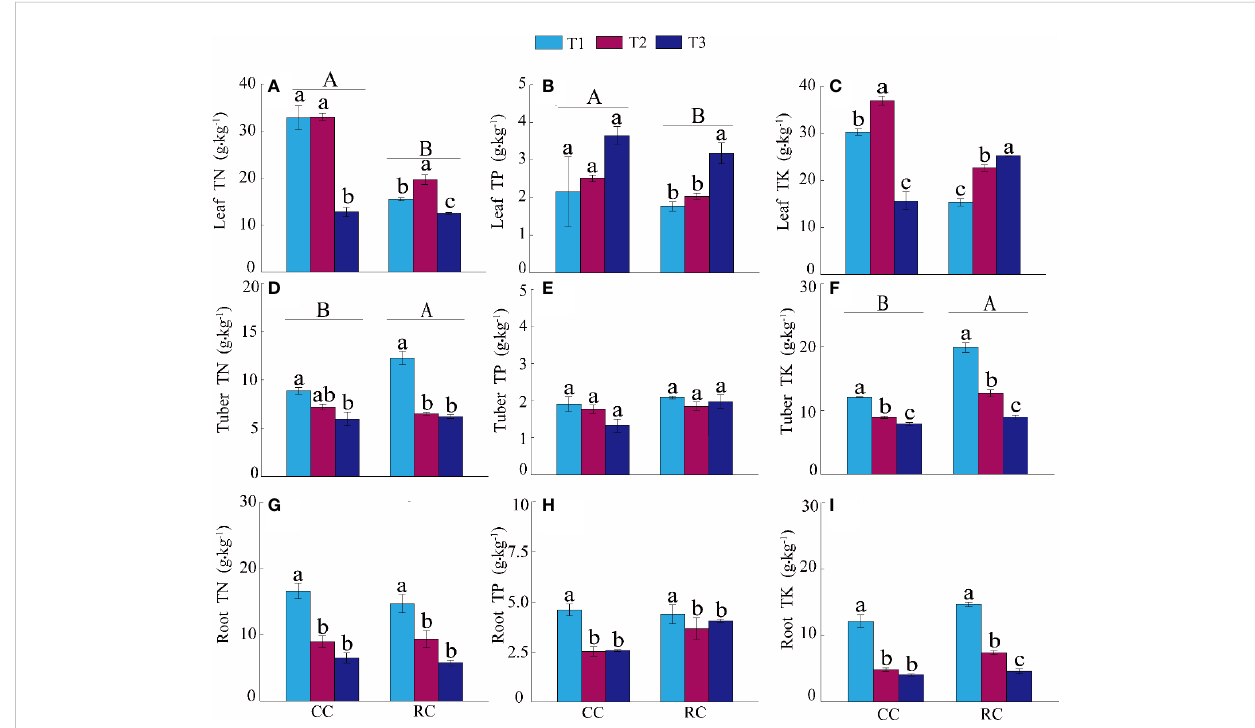
FIGURE 1 Effects of the continuous cropping (CC)/rotation cropping (RC) and mowing time on [ A (total nitrogen (TN)], B [total phosphorus (TP)], and C [total potassium (TK)] of the leaves, [ D (total nitrogen (TN)], E [total phosphorus (TP)], and F [total potassium (TK)] of the tubers, and [ G (total nitrogen (TN)], H [total phosphorus (TP)], and I [total potassium (TK)] of the